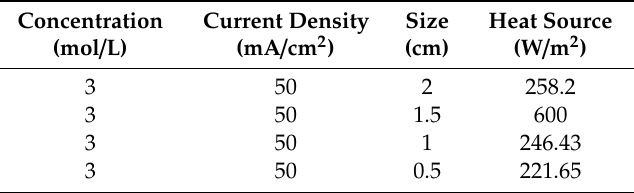
Table 4. Heat sources corresponding to di ff erent sizes of